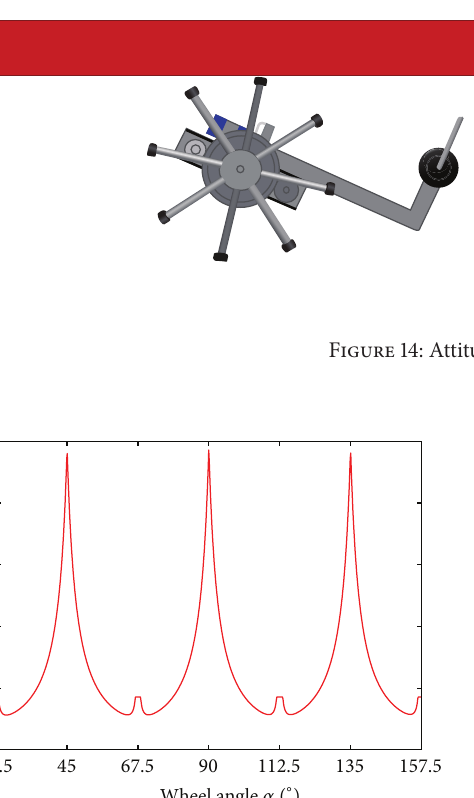
Wheel angle 𝛼 ( ∘ ) Figure 15: Relationship between rotation angle and the magnetic force of the whole of a rimless